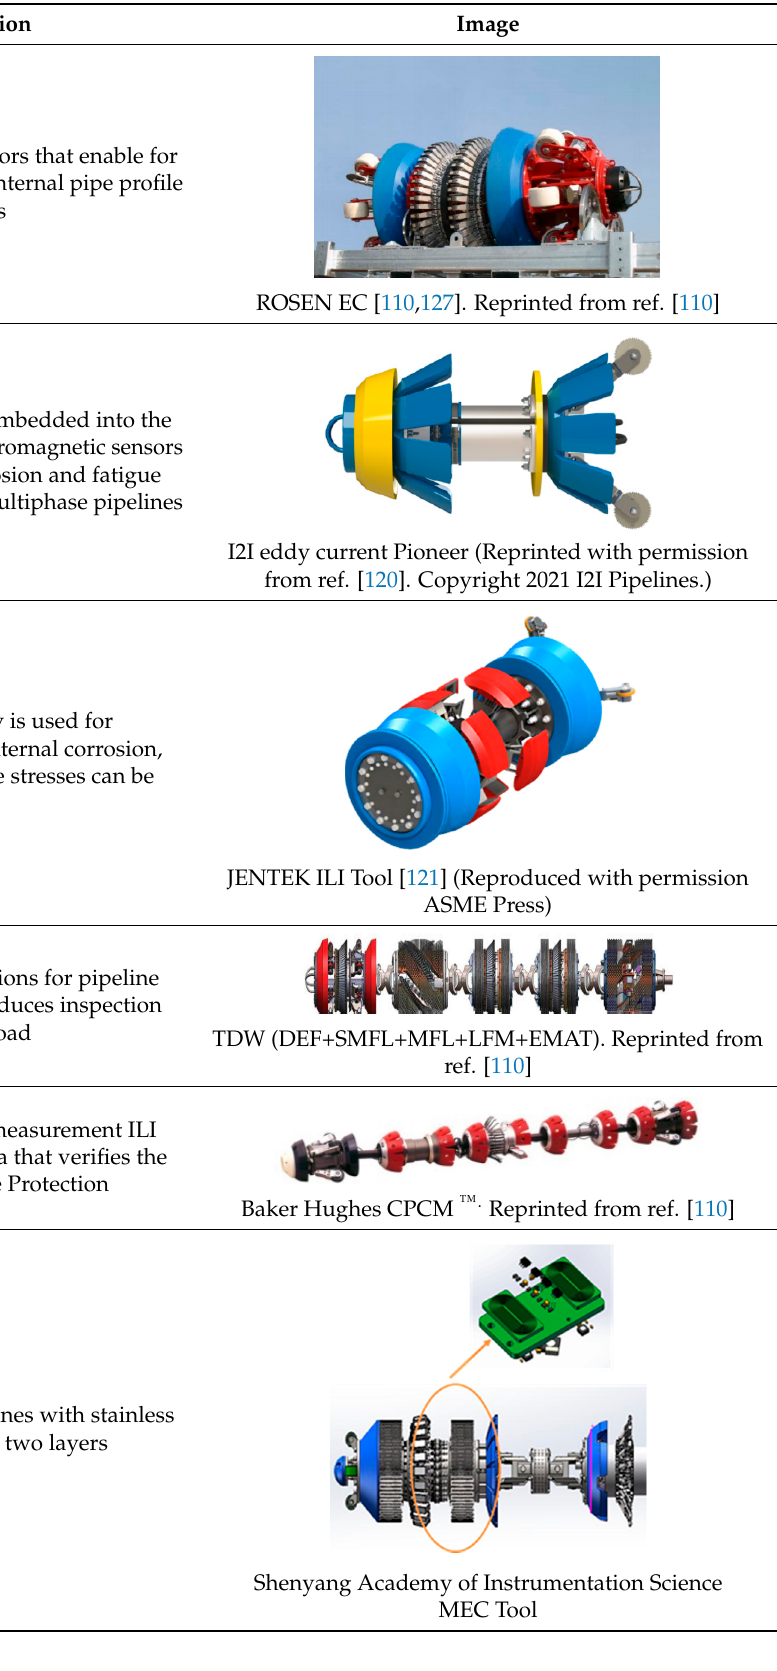
Table 5. Advice for the choice of commercial PIG. (Reprinted from ref. [110]). Consideration Parameters Metal Loss Features